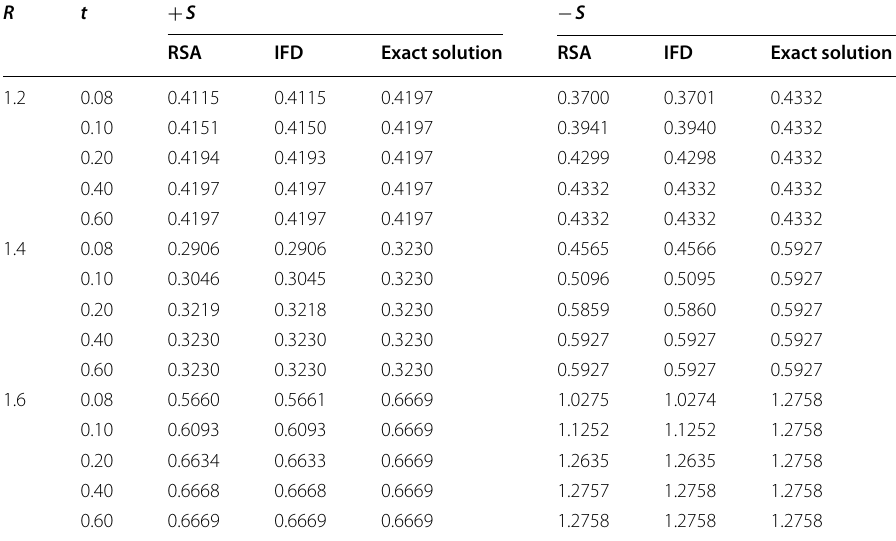
1.5, P 10,Da 0.02, A ∗ 1, w 0.8 ) = = = = =